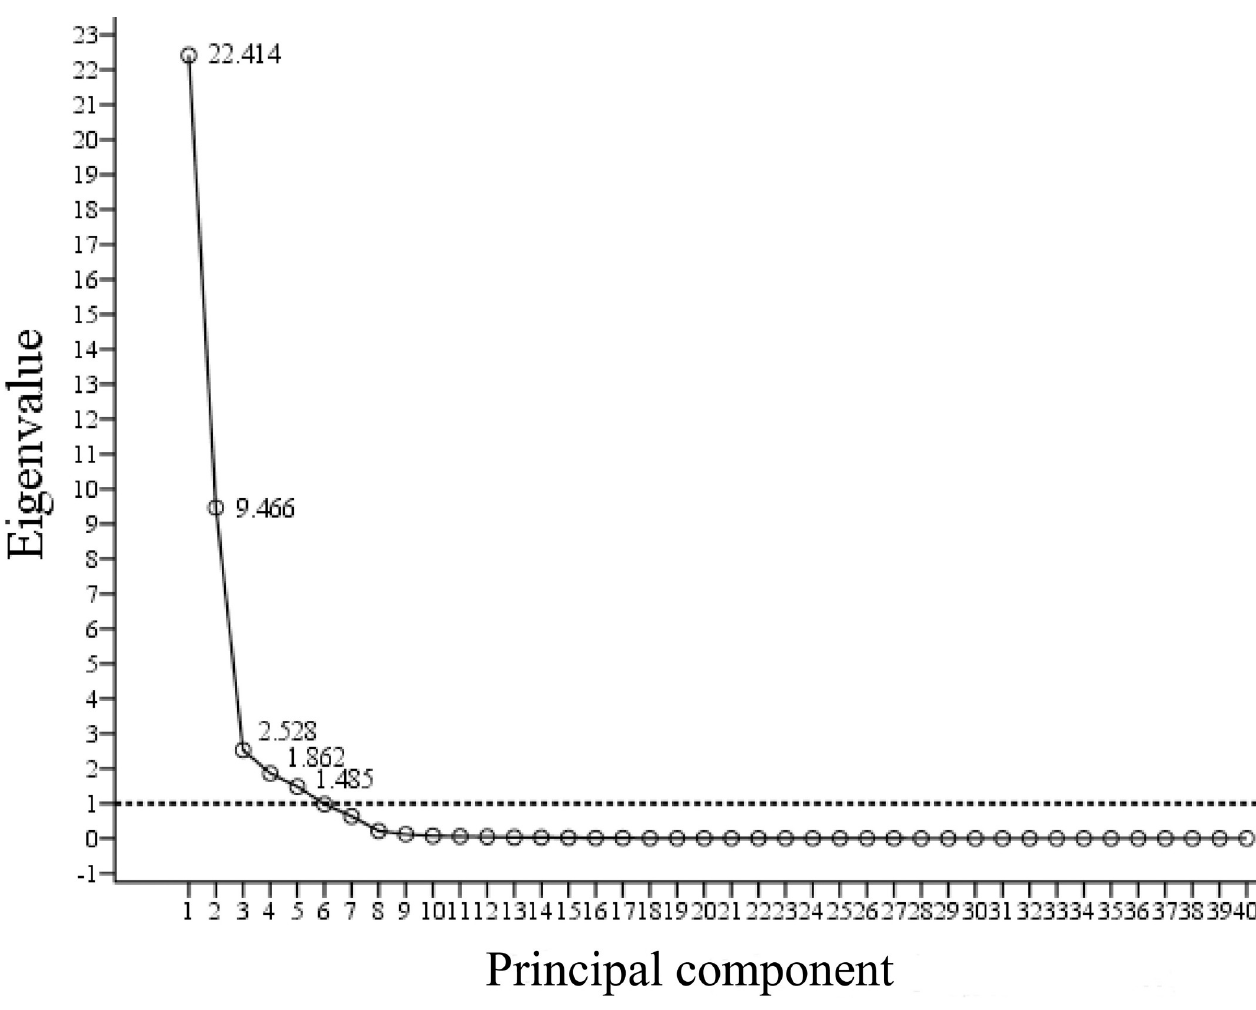
Fig 5. Principle components with their eigenvalues.